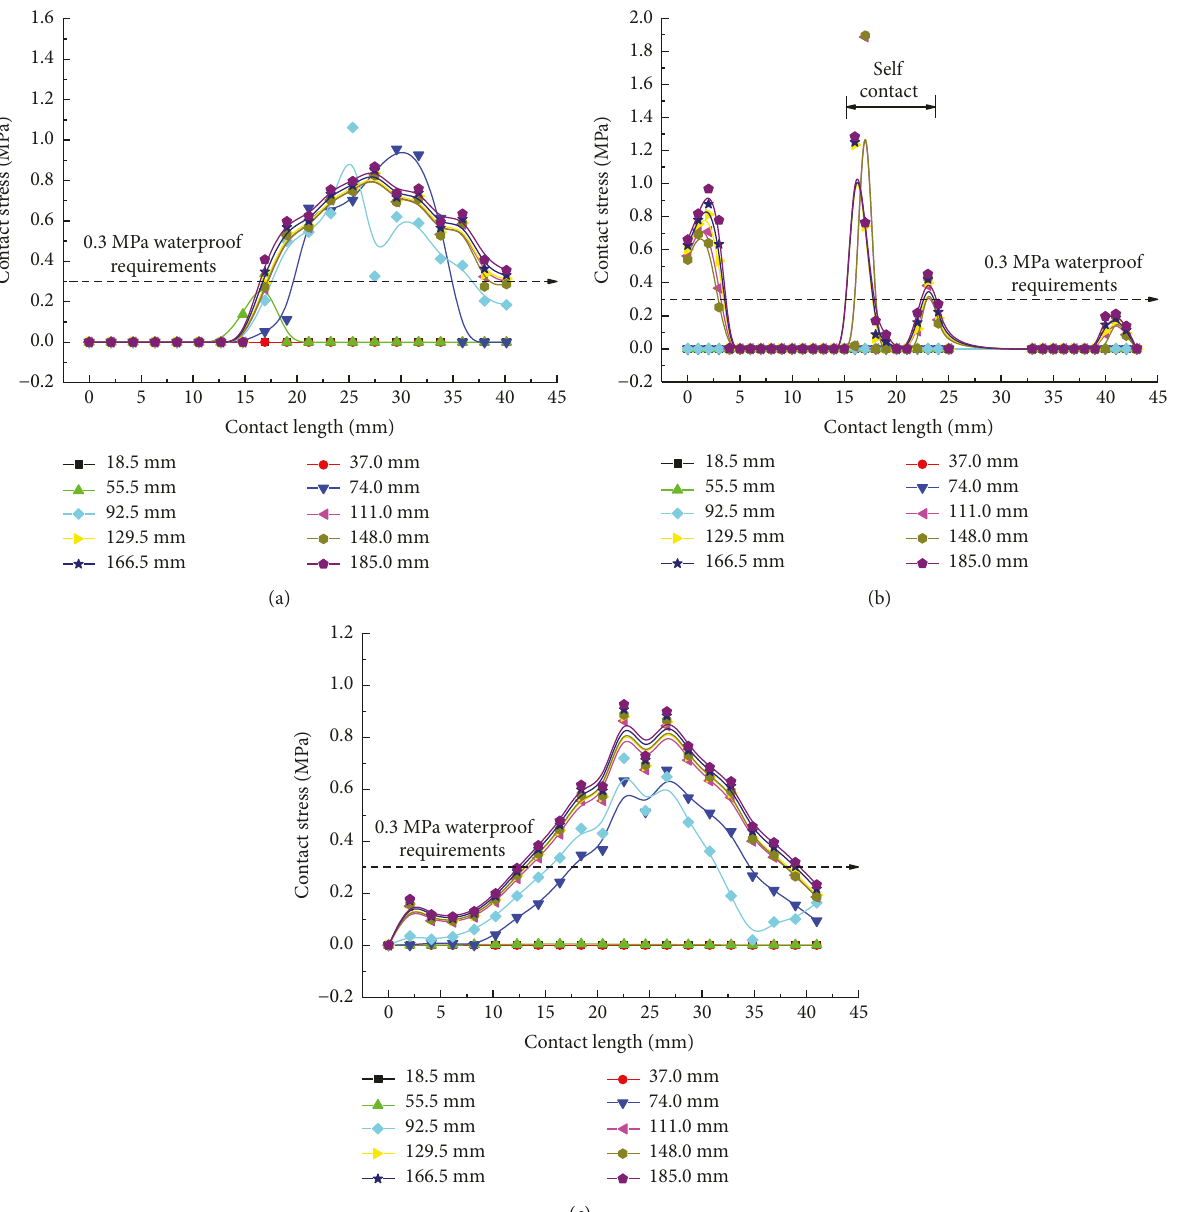
Figure 9: Contact stress curve of the first rubber ring after optimizing during translation: (a) contact pressure of line 1 for the first rubber ring, (b) contact pressure of line 2 for the first rubber ring, and (c) contact pressure of line 3 for the first rubber